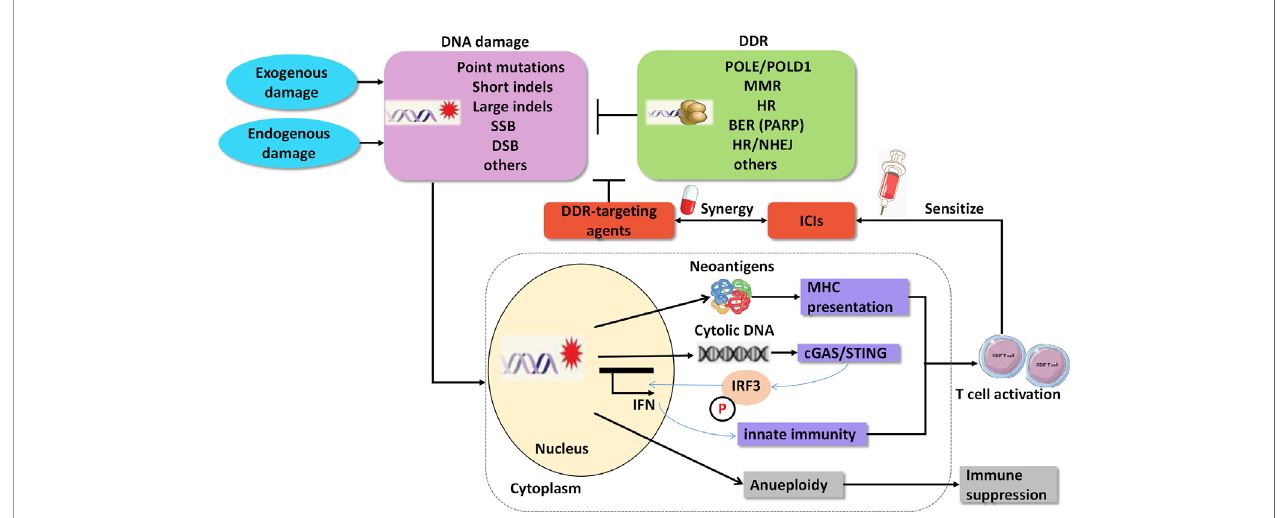
FIGURE 2 | Agents targeting DNA damage repair synergize with immune checkpoint inhibitors. SSB, single strand break; DSB, double strands break; DDR, DNA damage repair; MMR, mismatch Repair; HR, homologous recombination; BER, base excision repair; PARP, poly ADP-ribose polymerase; NHEJ, non-homologous end Joining; cGAS, cGAMP synthase; STING, stimulator of interferon